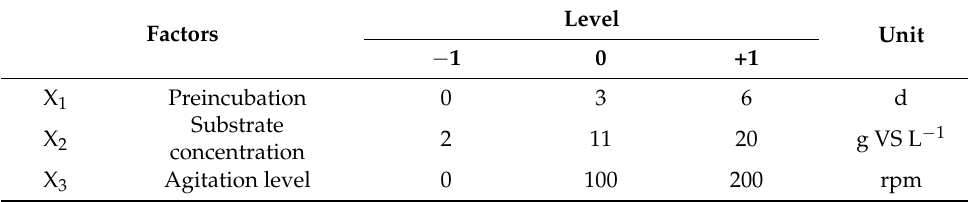
Table 3. Factors and levels evaluated by means of a 2 3 factorial experimental design.